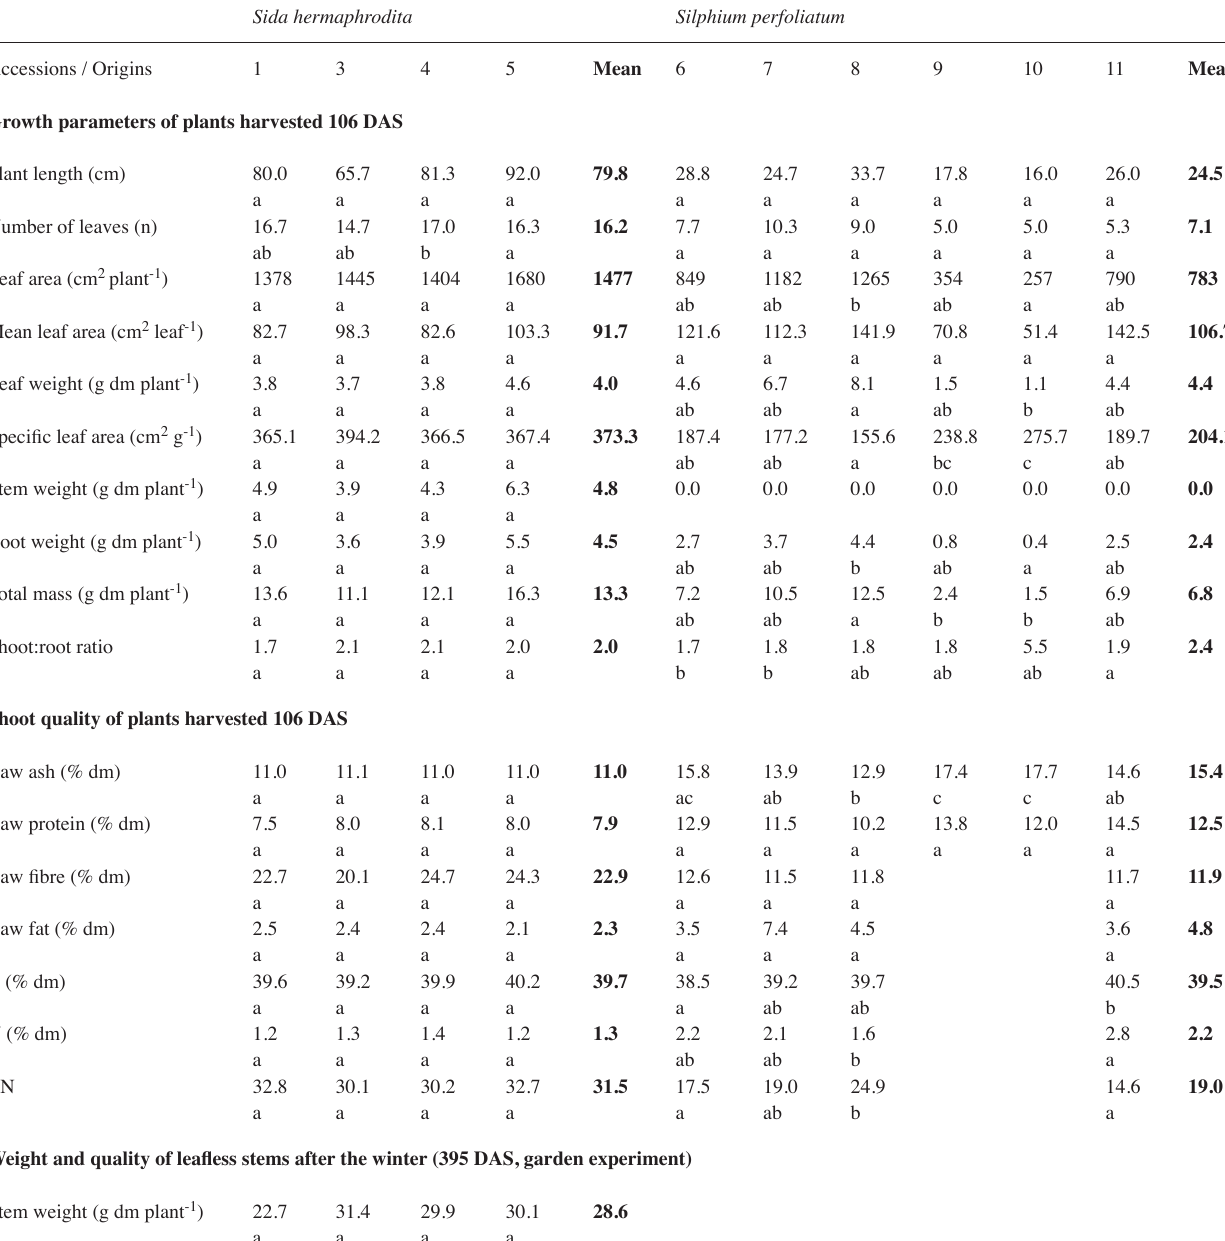
Tab. 2: Plant traits, growth and shoot quality of different accessions of Sida hermaphrodita and Silphium perfoliatum in the establishment phase (pot grown plants) and in plants that were grown for two seasons in a garden experiment. Pot grown plants were harvested 106 days after sowing (DAS) and weight and quality of stems of S. hermaphrodita was determined in field grown plants 395 DAS. Length increments and the onset of flowering of the ten accessions were followed in the second year in field grown plants. Different letters below the mean values indicate significant differences between the accessions (four replicates per origin) specified in Tab. 1. “DOY” indicates day of the